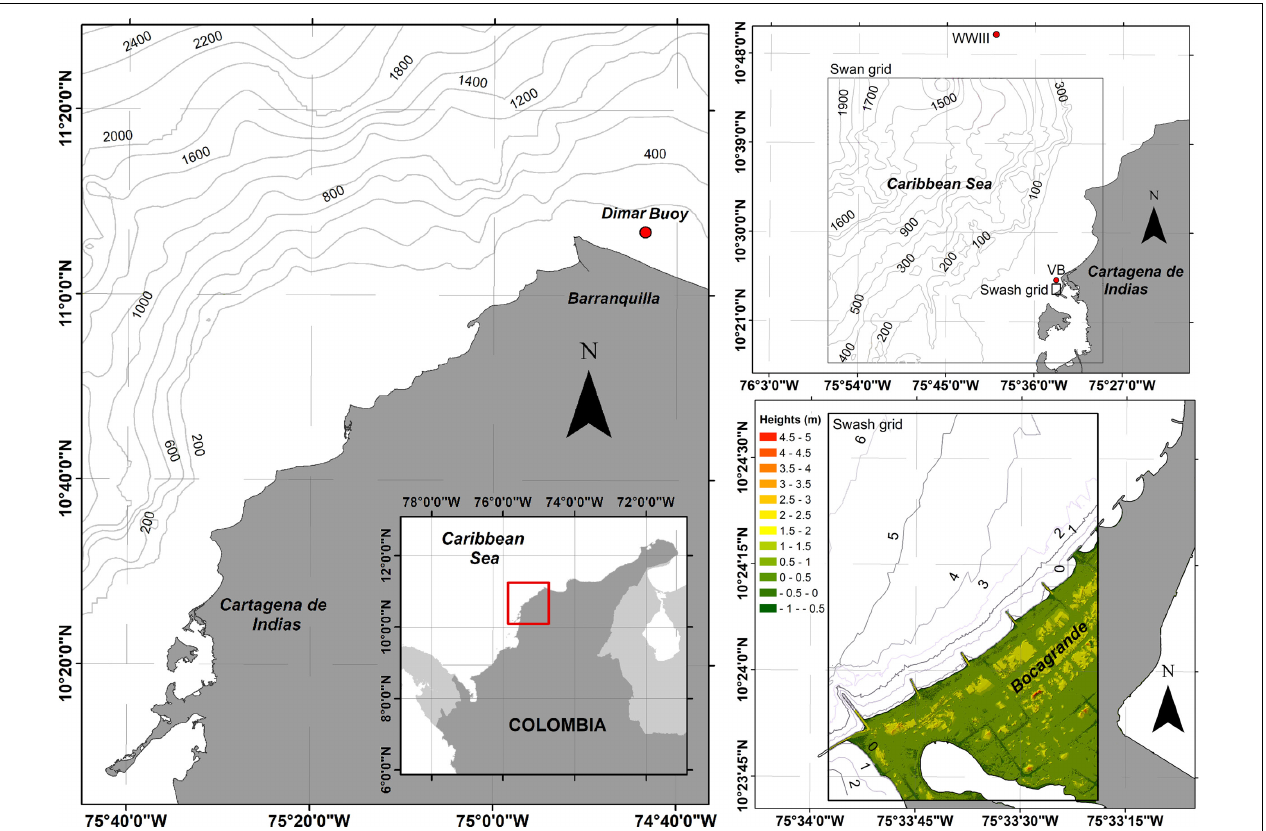
FIGURE 1 | Study area representation. Indicates the location of the computational domain of SWAN and SWASH models in the right panel . The red dot in the left panel indicates the NOAA buoy used for the SWAN model validation. The bottom right panel shows the elevation of the dry area.